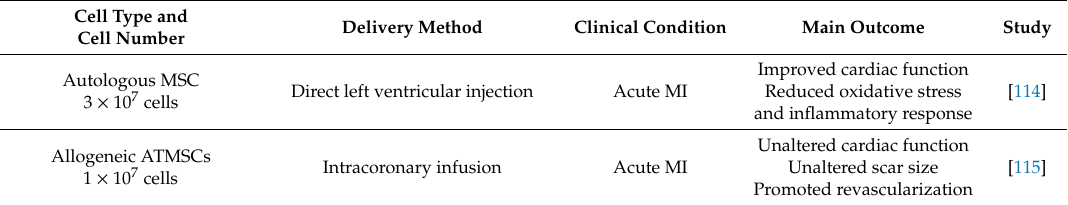
Table 1. Studies on the e ff ect of porcine mesenchymal stem cells in heart regeneration. The table outlines the conditions and outcomes of mesenchymal stem cell-based therapies in several cardiovascular ATSCs: adipose tissue-derived stem cell, CDCs: Cardiosphere-derived